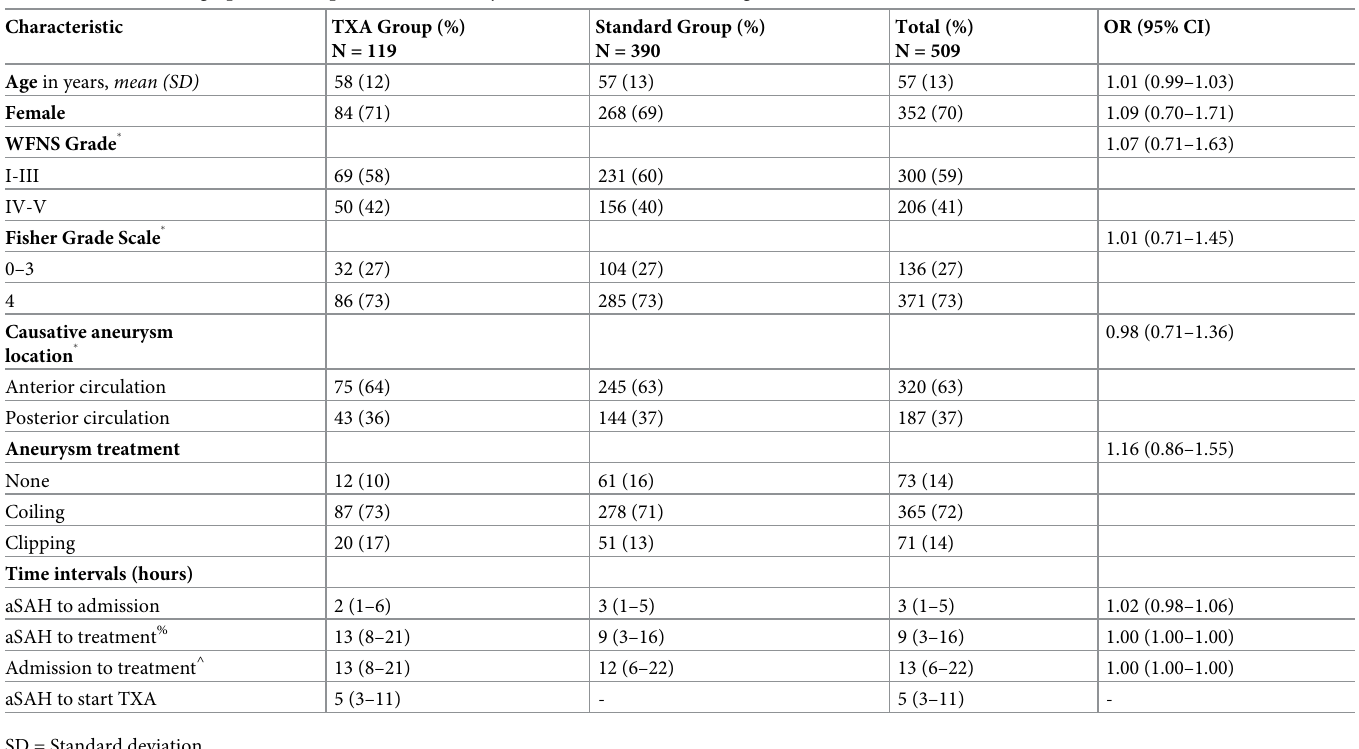
Table 1. Baseline demographics of 509 patients with aneurysmal subarachnoid hemorrhage. Characteristic